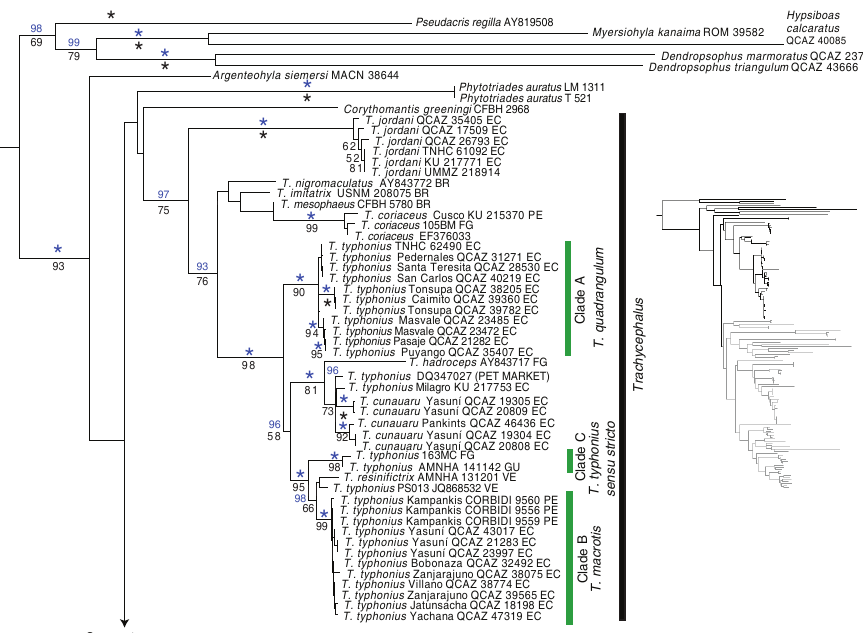
Figure 1. Maximum likelihood phylogram showing the position of Tepuihyla tuberculosa comb. n. and Tepuihyla shushupe sp. n. within Hylidae. Phylogram derived from analysis of 3792 bp of mitochondrial (gene fragments 12S , 16S , ND1 , CO1 , tRNA Leu , tRNA Ile , tRNA Gln ) and nuclear DNA (POM-C). Vouch- er no. (or, if unavailable, GenBank accession no.) is shown for each sample. Clade posterior probabilities (pp × 100) resulting from Bayesian Markov chain Monte Carlo searches appear above branches in blue. Non-parametric bootstrap (npb) support values, from 200 pseudoreplicates, are shown below. Asterisks represent values of 100. Outgroups are not shown. Abbreviations are: BR = Brazil, EC = Ecuador, FG = French Guiana, GU = Guyana, PE = Peru, VE =